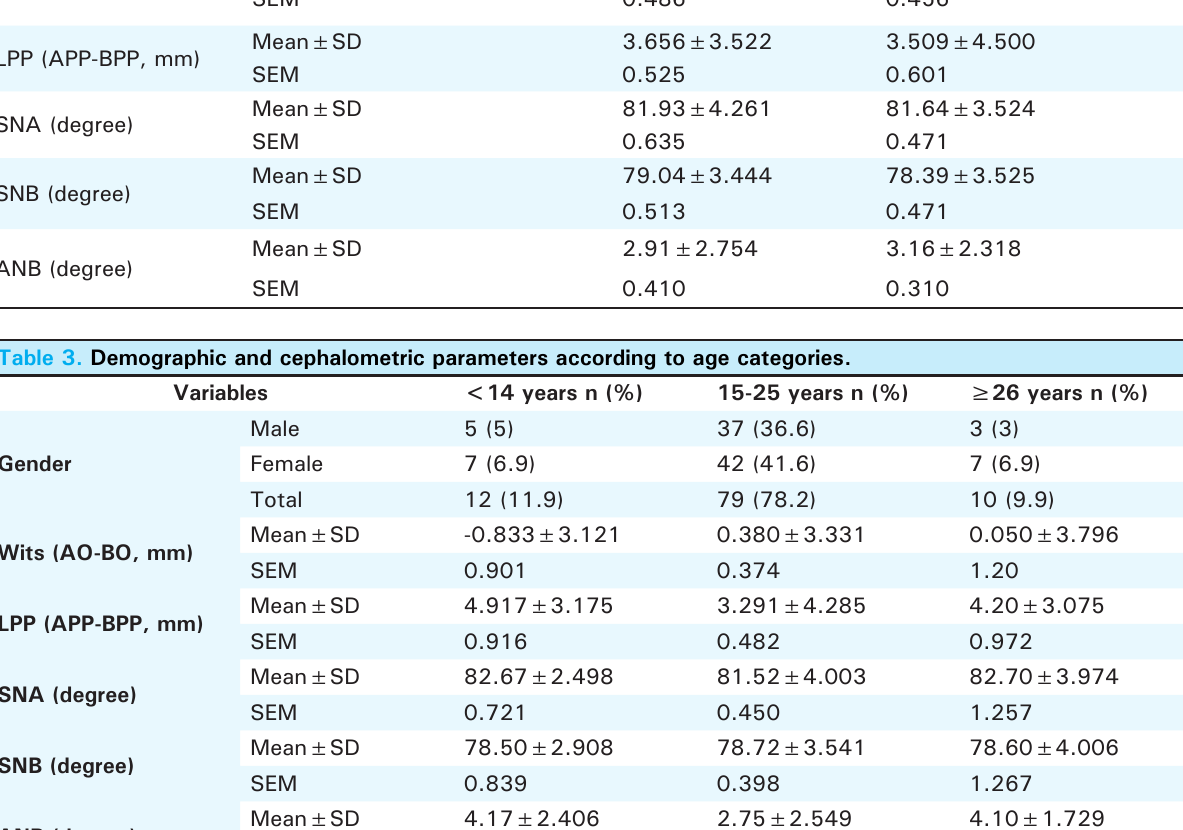
Table 2. Demographic and cephalometric parameters according to sex.